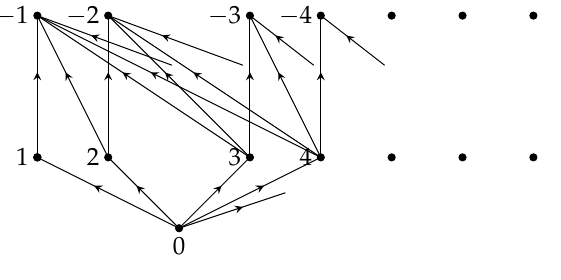
Figure 1. The poset ( Z , (cid:54) )